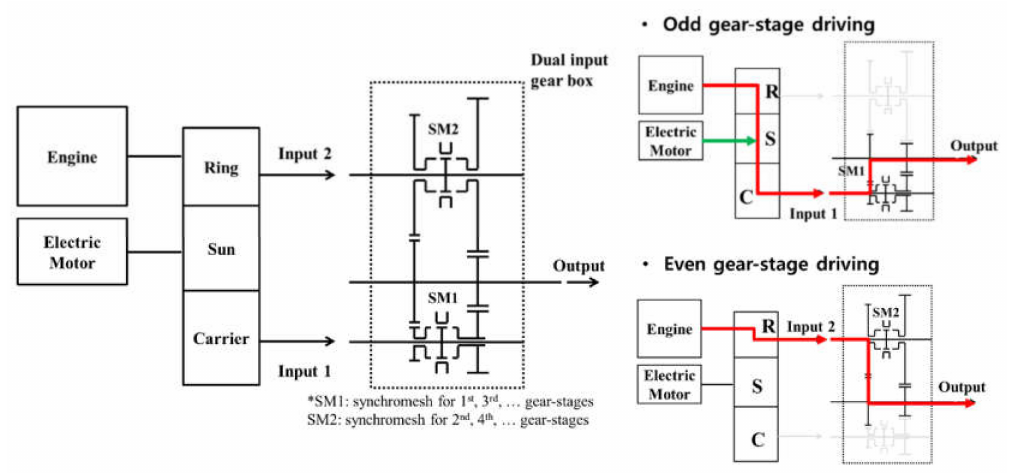
Figure 3. Schematics of dual input gear-box of the CGST (clutchless geared smart transmission). Based on this mechanism, CGST can shift gears through sequential shifting steps without a clutch [22,23]. The cases of gear-shifting of CGST can be divided into three kinds of unique gear-shift mechanism: (i) starting from a standstill, (ii) shifting from odd gear-stage to even gear-stage, (iii) shifting